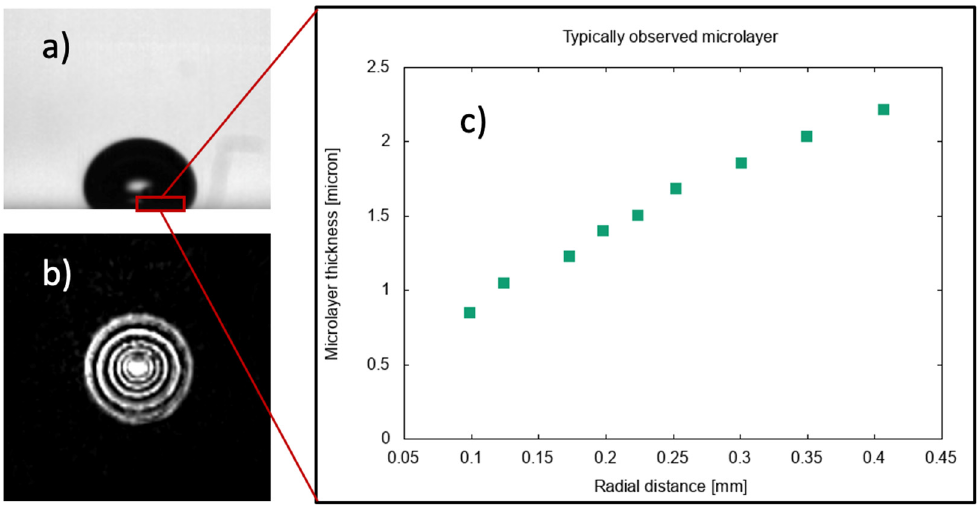
Figure 1. Observations of the microlayer in boiling at a surface. ( a ) Typical bubble shape during the early stages of growth. ( b ) Interferometric measurements of phase distribution on the solid surface used to detect the presence of a liquid film. ( c ) Measured microlayer thickness as a function of radial distance from the center of the bubble base. Data [1] for pool boiling of water in atmospheric conditions at 10 K of wall superheat.